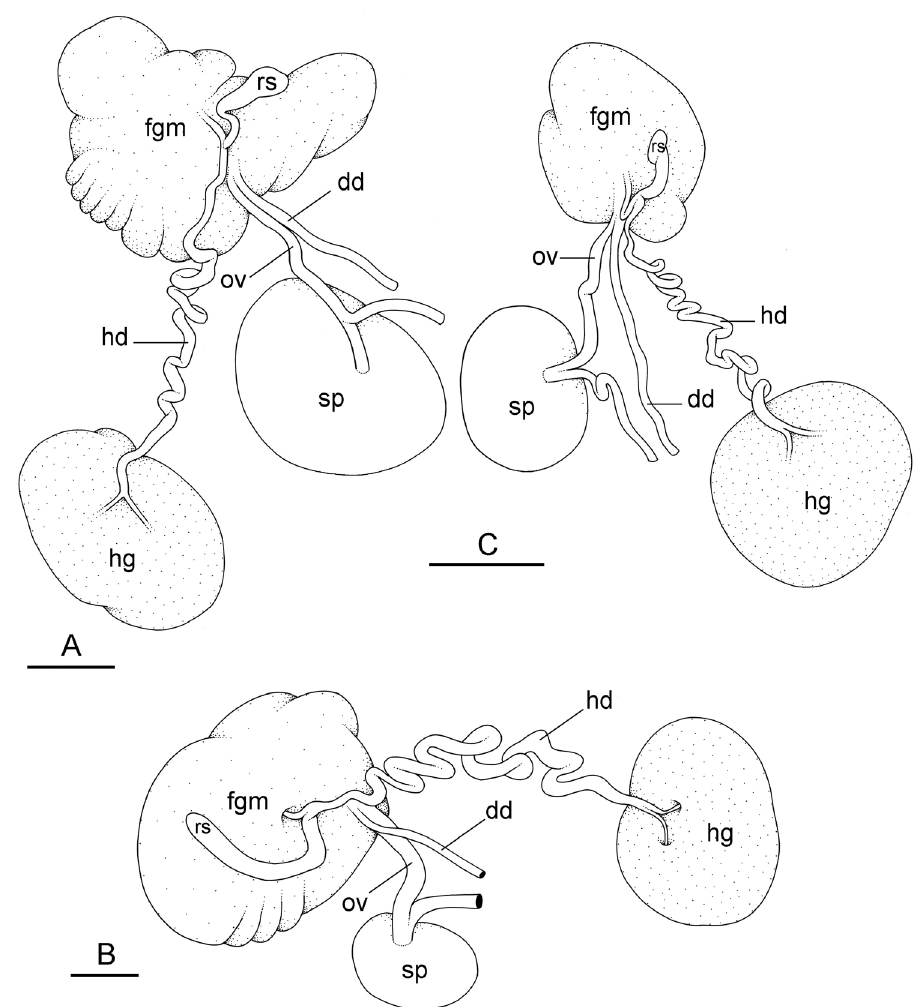
Figure 63. Reproductive system, hermaphroditic (female), posterior parts, Wallaconchis melanesiensis. A Indonesia, Halmahera, scale bar 2 mm [5131] (UMIZ 00069) B Vanuatu, scale bar 1 mm [5484] (IM- 2013-62406) C Indonesia, Lombok, scale bar 2.4 mm [2963] (UMIZ 00070). Abbreviations: dd defer- ent duct fgm female gland mass hd hermaphroditic duct hg hermaphroditic gland ov oviduct rs recep- taculum seminis sp